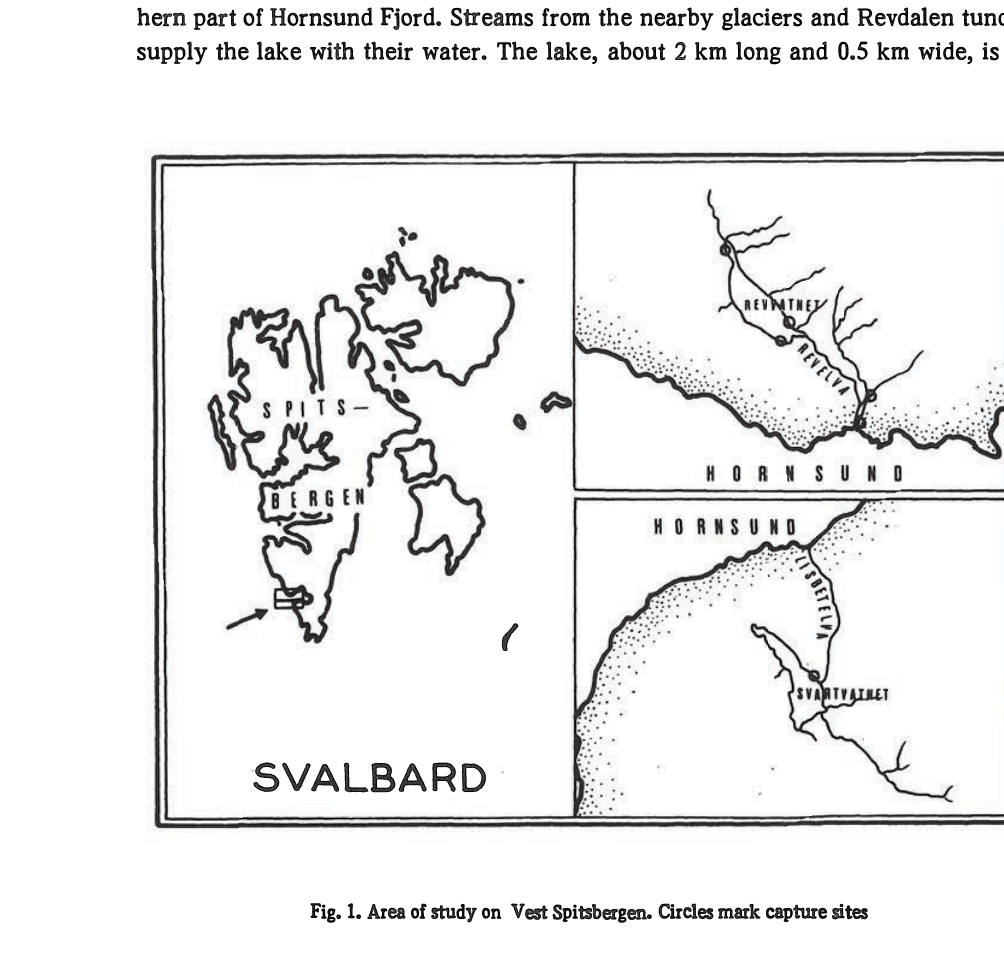
Fig. 1. Area of study on Vest Spitsbergen. Circles mark capture